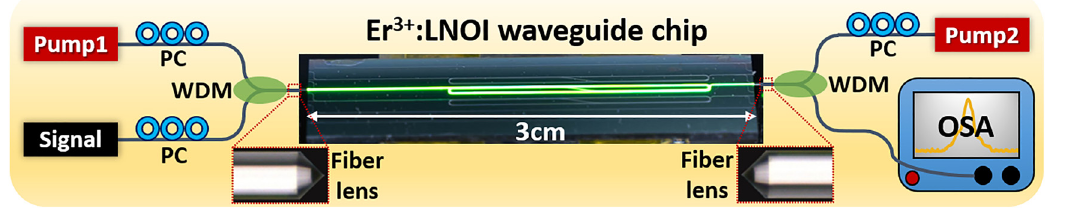
Figure 2: The experimental setup for optical gain measurement. PC, polarization controller. WDM, wavelength division multiplexer. OSA, optical spectrum analyzer. The digital camera photograph of the excited Er 3 + :LNOI waveguide chip is shown in the